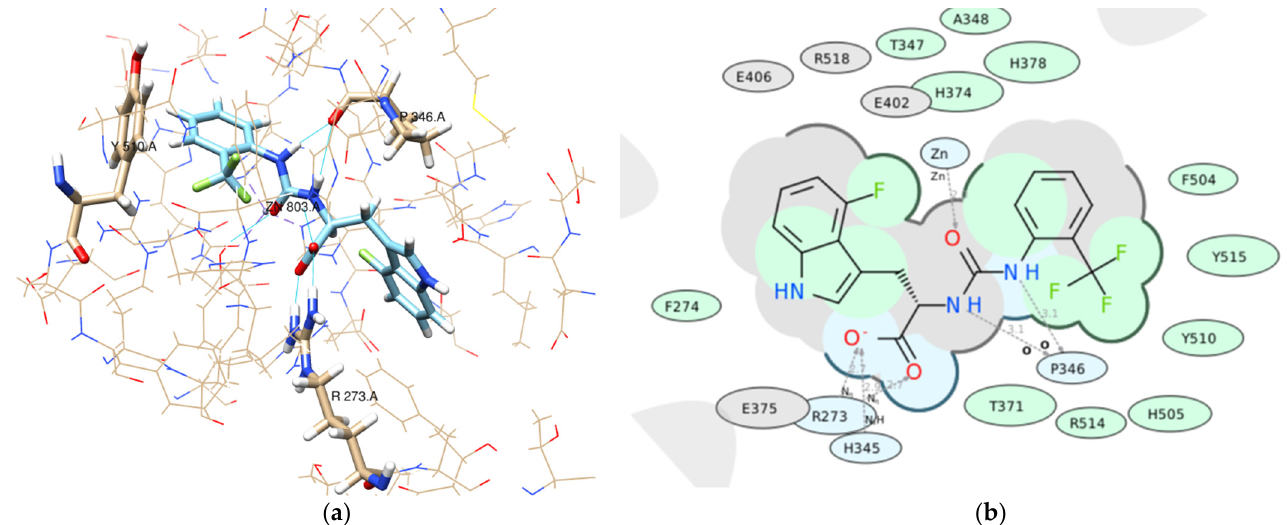
Figure 9. ( a ) 2d diagram of the interaction of Z4221819990 and ACE2 in the active site; ( b ) 3d visualization of the interaction